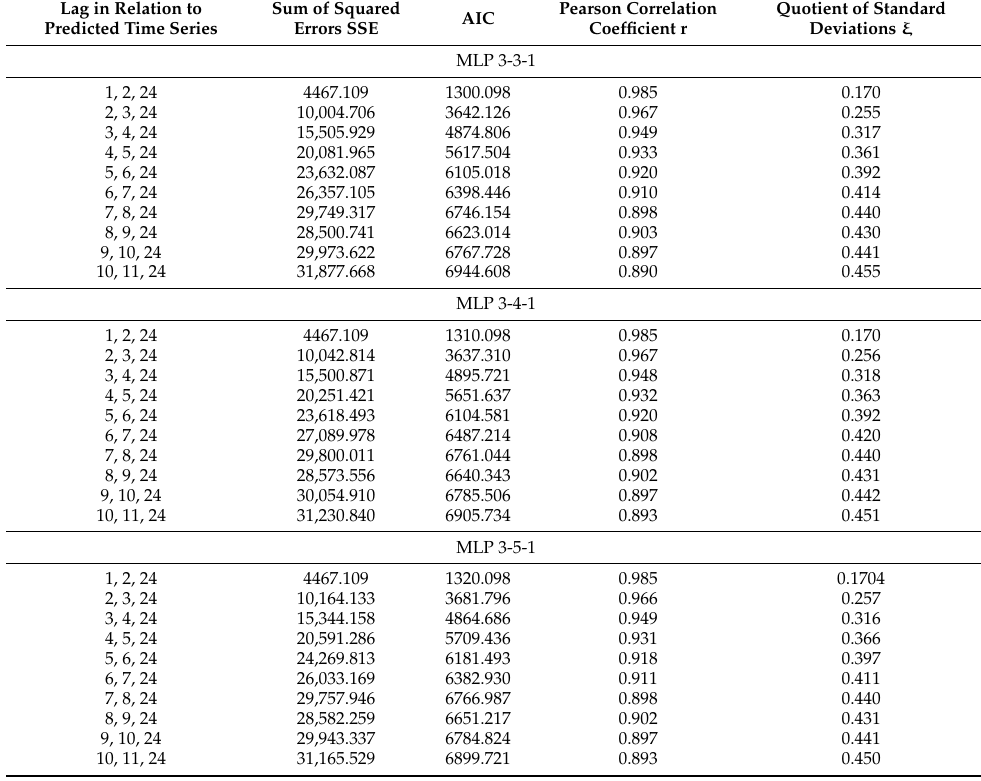
Table 2. Prediction results for MLP 3-3-1, 3-4-1 and